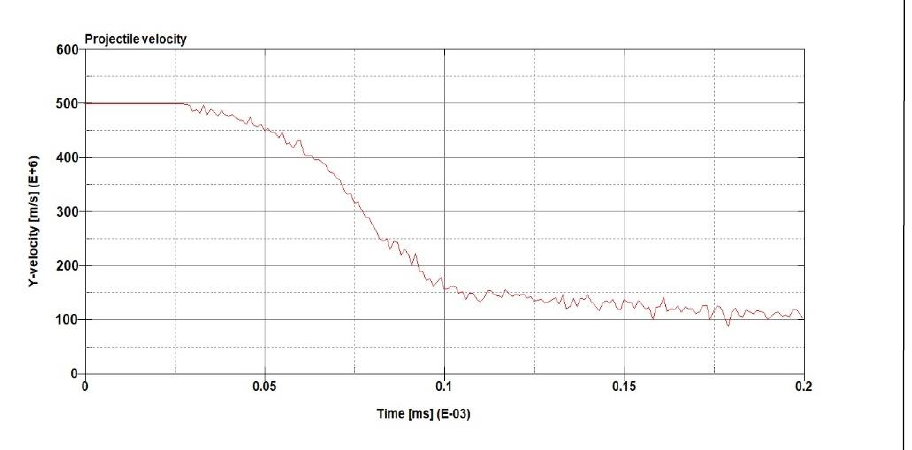
Figure 22 – Velocity of the projectile in relation to time Рис. 22 – Cкорость снаряда в зависимости от времени Слика 22 – Брзина пројектила у зависности од времена